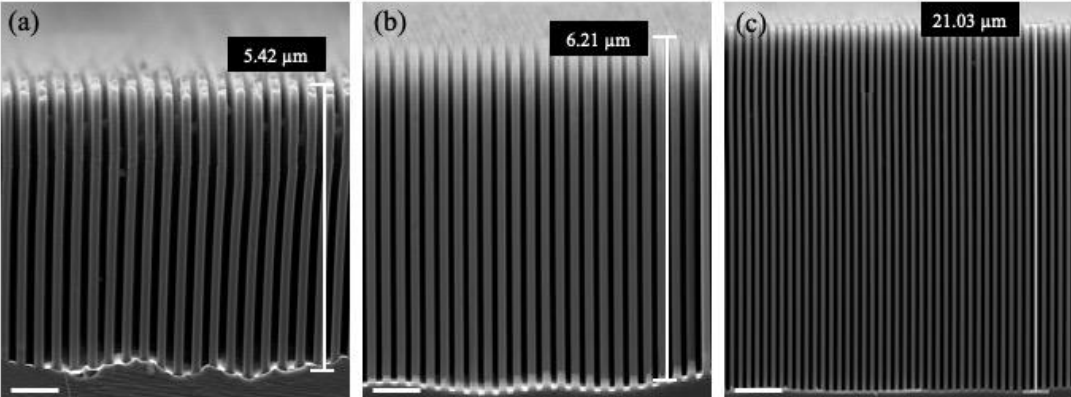
Figure 2. Cross-sectional scanning electron microscope (SEM) micrographs of silicon nanostructures using various etchant solutions composed of hydrofluoric acid, hydrogen peroxide solution, and deionised (DI) water with molar ratios of ( a ) 4.8:0.35:50, ( b ) 4.8:0.15:50, and ( c ) 4.8:0.15:50. The scale bars in ( a – c ) are 850 nm, 900 nm, and 1.9 µ m, respectively. The etching temperatures in ( a , b ) are 22 ◦ C, and the etching temperature in ( c ) is 2 ◦ C.